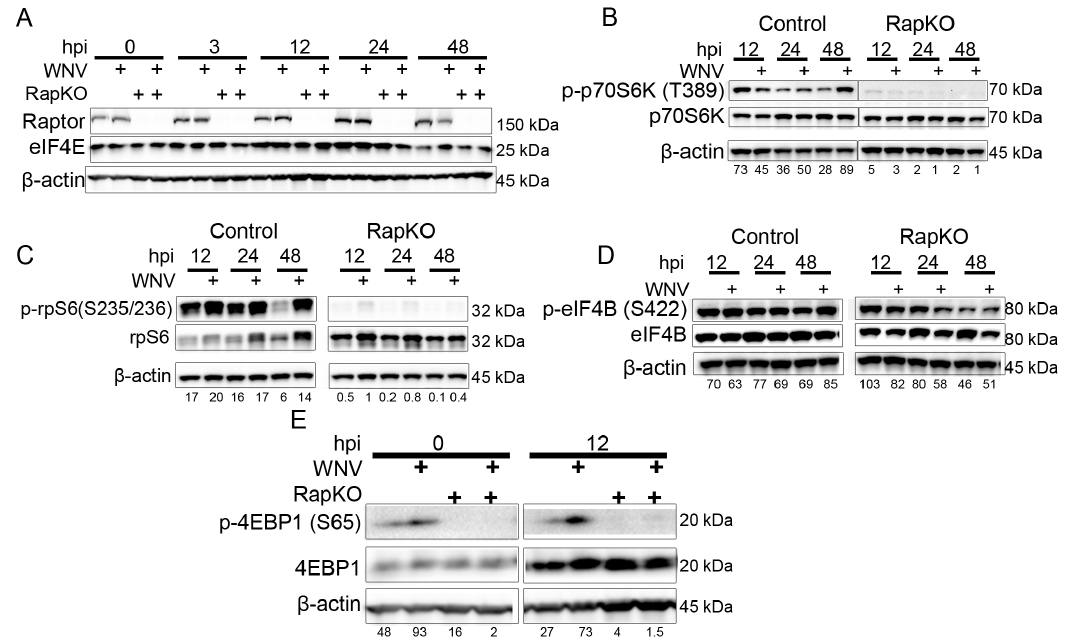
Figure 3. Raptor knockout results in a loss of p70S6K and 4EBP phosphorylation. Cells were either mock- or WNV-inoculated (MOI = 3) in control and iRapKO MEF cells, total cellular protein lysates were collected at the indicated hpi, and probed using antibodies for the indicated target proteins by western blot analysis. ( A ) Expression of Raptor and eIF4E; ( B ) Expression of phospho-p70S6K (tyrosine 389) and total p70S6K; ( C ) Expression of phospho-rpS6 (serine 235/236) and total rpS6. ( D ) Expression of phospho-eIF4B (serine 422) and total eIF4B; ( E ) Expression of phospho-4EBP1 (serine 65) and total 4EBP1. All images are representative of two independent experiments. β -actin was used as the loading control for all experiments. Densitometry values are provided for phospho-protein expression and corrected for β -actin expression.